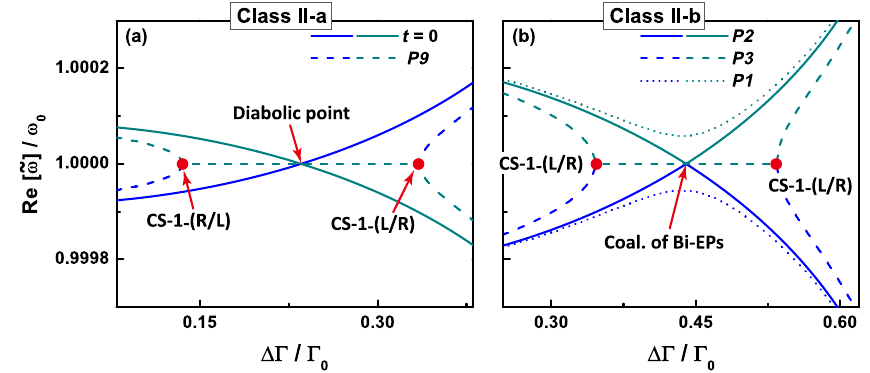
FIG. 5. Real parts of eigenfrequencies as functions of asymmetric loss for the point P 9 in the phase diagram shown in Fig. 2(b) near the two CS- 1 − are shown in (a) by dashed lines with system parameters ω 0 ¼ 3427 . 59 rad = s, κ ¼ − 2 . 5 rad = s, t ¼ − 0 . 5 rad = s, and Γ 10 rad = s. For comparison, the solid lines in (a) are for t ¼ 0 rad = s while keeping all the other parameters the same with point P 9 . 0 ¼ Real parts of eigenfrequencies as functions of asymmetric loss for the points P 1 , P 2 , and P 3 in the phase diagram shown in Fig. 2(b) near the two CS- 1 − are shown in (b) by dotted lines, solid lines, and dashed lines, respectively. The letters in the bracket following CS- 1 − indicate the relative chirality of this EP.